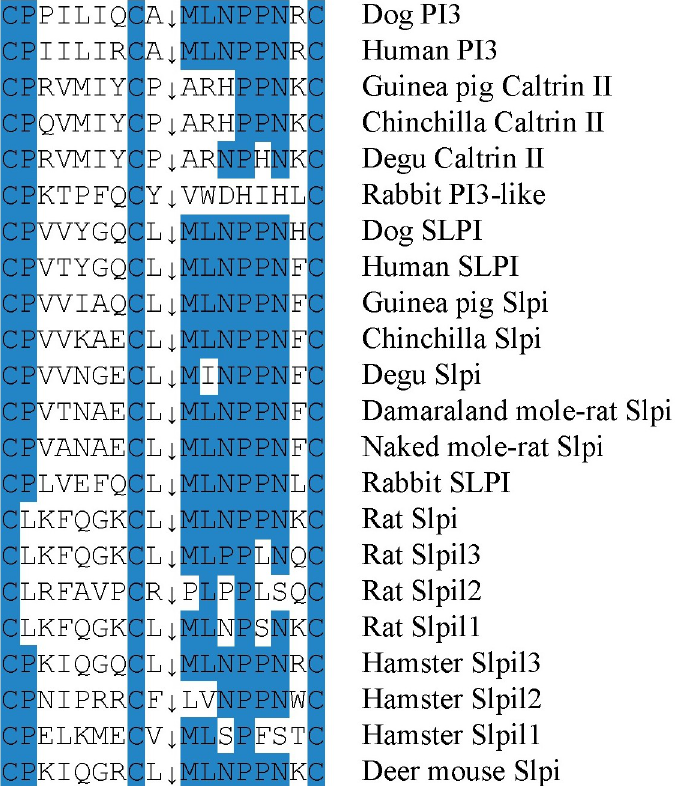
Fig 11. Conservation of the active site in PI3 and SLPI. The conserved primary structures at the active site of the human and dog elastase inhibitors PI3 and SLPI are shown together with rabbit and rodent homologs. The scissile bonds are indicated by arrows. Residues that are highlighted in blue are fully conserved at the active site of the human and dog